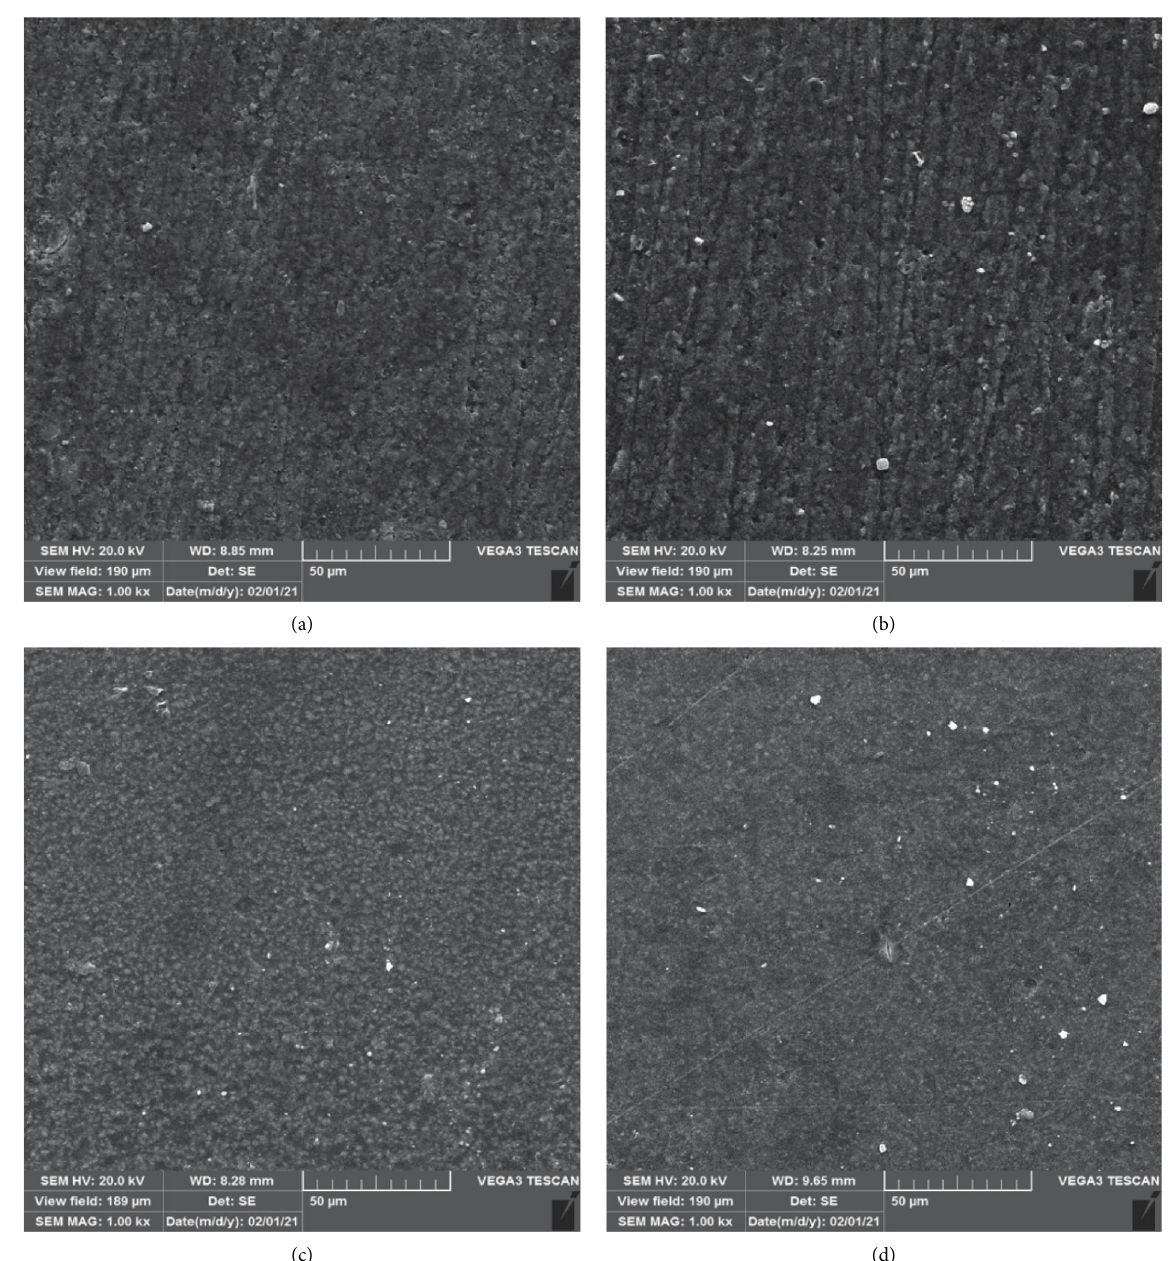
Figure 1: Scanning electron microscopy micrographs of the specimen surfaces with 1000 × magnification: (a) the control group, (b) the 0.3% (w/w) BCNs-modified RMGIC group, (c) the 0.5% (w/w) BCNs-modified RMGIC group, and (d) the 0.3% (w/w) BCNs-modified RMGIC